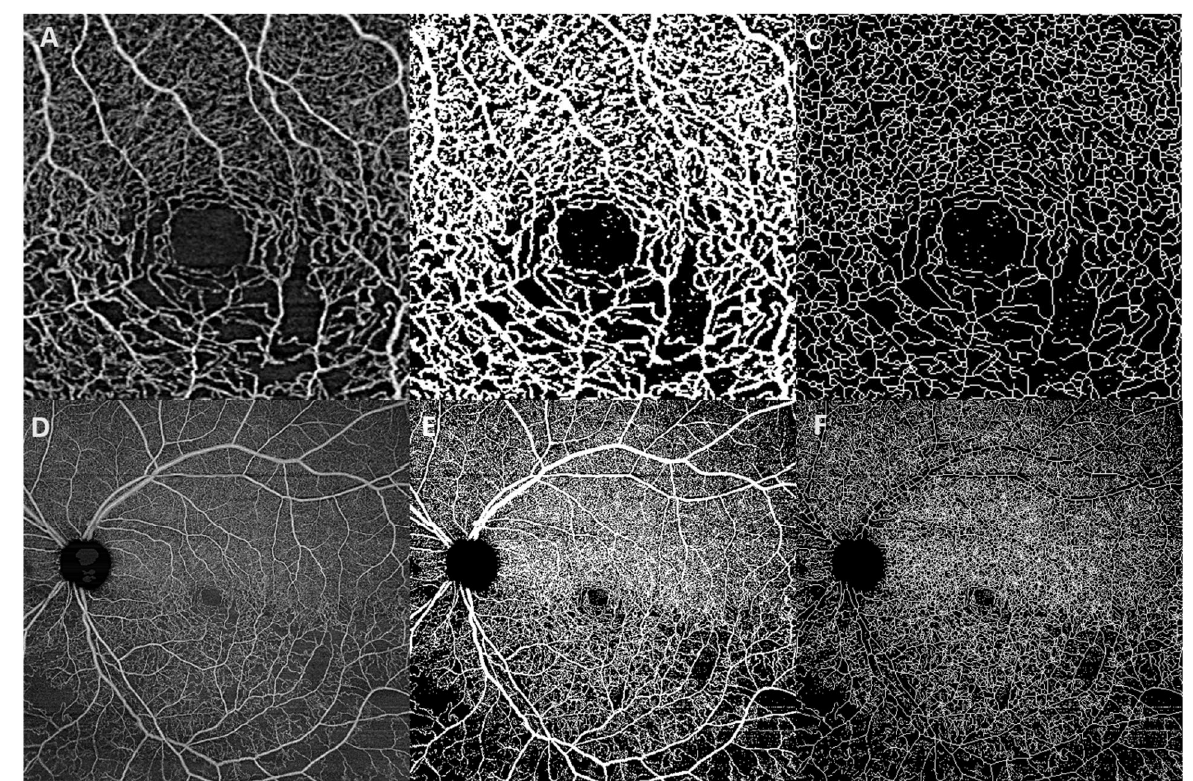
Figure 1. Image analysis of the SS-OCT angiography of the affected eye of a 72-year-old woman with a branch retinal vein occlusion: ( A ) A 3 mm × 3 mm macular image of the retinal layer of the affected eye. ( B ) The 3 mm × 3 mm macular image after the thresholding algorithm is applied. ( C ) The 3 mm × 3 mm skeletonized image of the retinal layer. ( D ) A 12 mm × 12 mm image of the retinal layer of the affected eye. ( E ) The 12 mm × 12 mm image of the retinal layer after the thresholding algorithm is applied. ( F ) The 12 mm × 12 mm skeletonized image of the retinal layer.